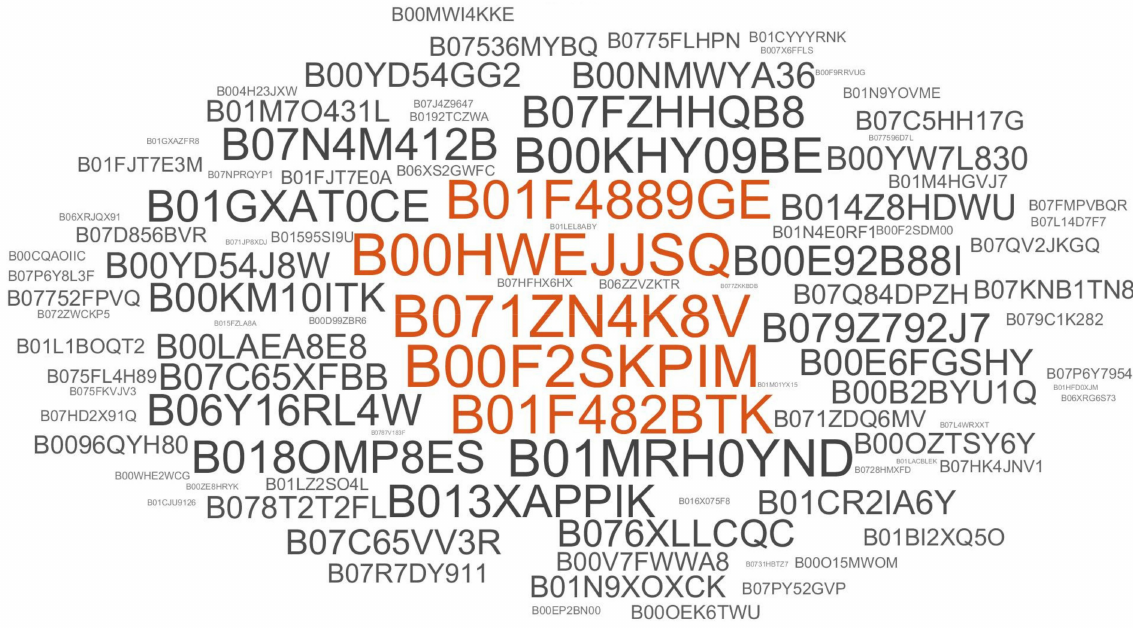
Figure 13. Word-cloud plot analysis for products and their total number of